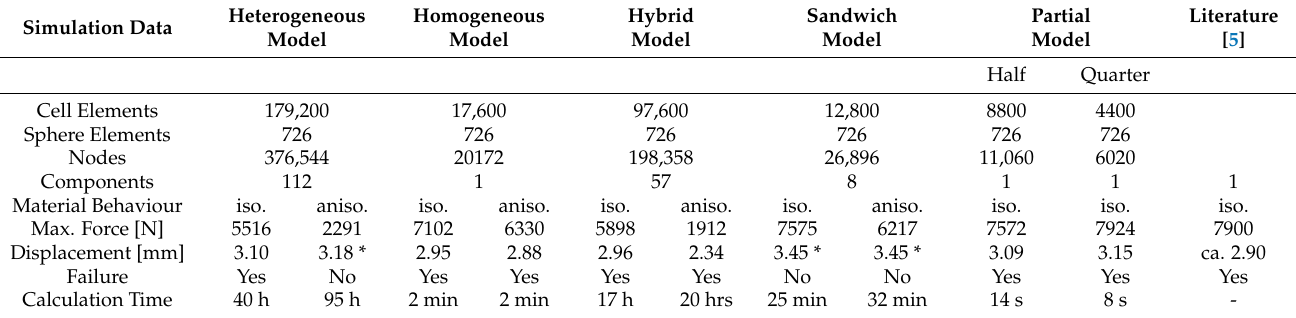
Table 1. Summary of all simulation